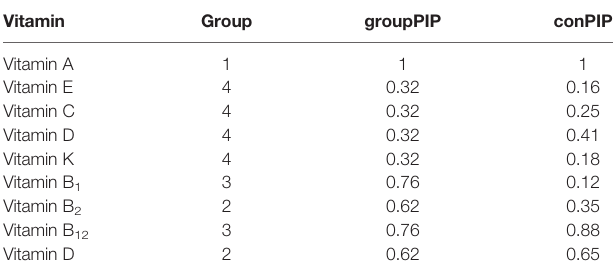
PIPs, posterior inclusion probabilities; BKMR, Bayesian kernel machine regression. Model were adjusted for age, sex, education level, race/ethnicity, poverty-income ratio, serum cotinine and daily energy